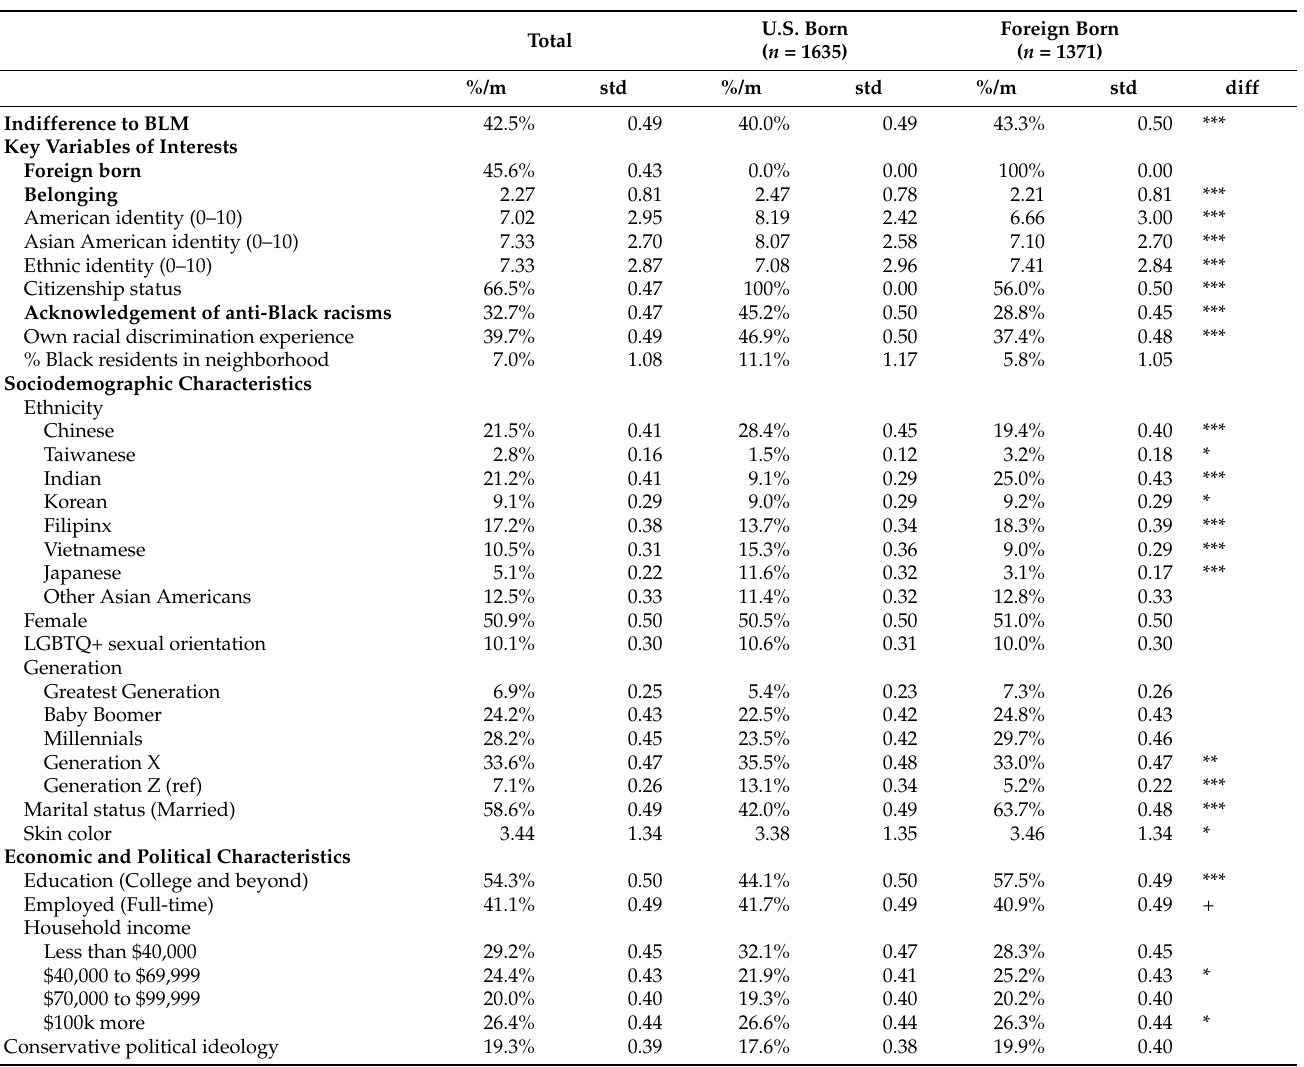
Table 2. Weighted descriptive statistics of all variables for Asian Americans, by nativity. Source: 2016 Collaborative Multiracial Post-election Survey (CMPS). Note: Statistics a Significant tests of difference compared to U.S.-born Asian Americans, p < 0.05 (one-tailed test); * p < 0.05, ** p < 0.01, *** p < 0.001, + p <